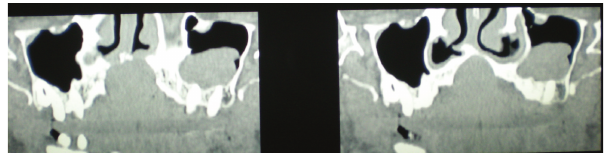
Figure 5: Panoramic reconstruction of CT scan.